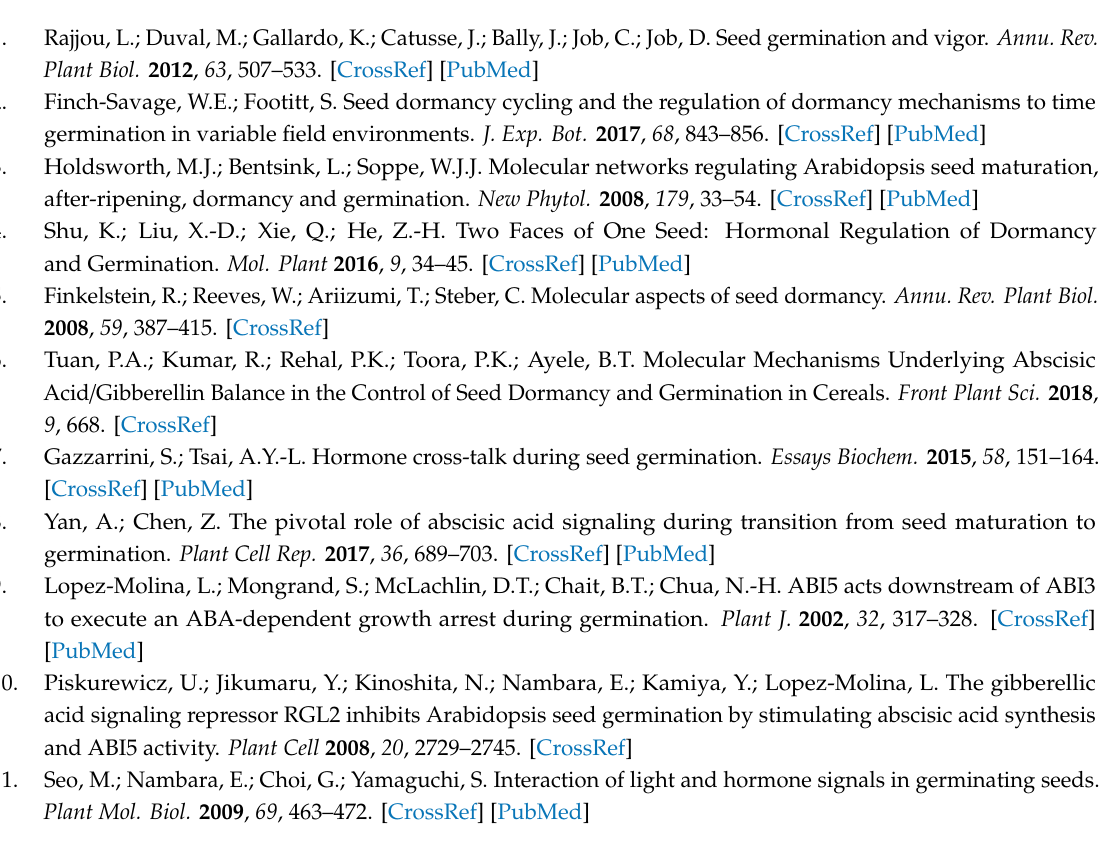
Figure S1: Seed germination on 1 / 2 MS, nitrogen components of 1 / 2 MS (DW + N), and DW in the presence of ( A ) 170 mM NaCl, ( B ) 278 mM glucose, and ( C ) no additional compounds (control)., Figure S2: The e ff ect of KCl and NH 4 Cl on seed germination in the presence of ( A ) 170 mM NaCl and ( B ) 278 mM Glucose., Figure S3: Expression of genes involved in the regulation of seed germination in the presence ( + N) or absence ( − N) of 10 mM KNO 3 ., Figure. S4. Seed germination on 1 / 2 MS, nitrogen components of 1 / 2 MS (DW + N), and DW in the presence of 1 µ M ABA. Table S1: List of genes used in this study., Table S2: Primers used in this